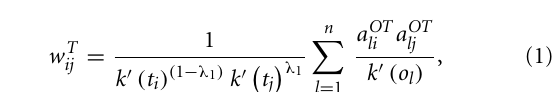
FIGURE 1 | Operating principle of ncPred in a tripartite network . Here, we represent ncRNAs in blue, targets in orange, and diseases in red.Without loss of generality, and in order to simplify the reading of the image, we decided to put λ 1 and λ 2 to 1, so as to obtain a uniform distribution of resources in the network. In the first step, a resource is assigned to each target and disease